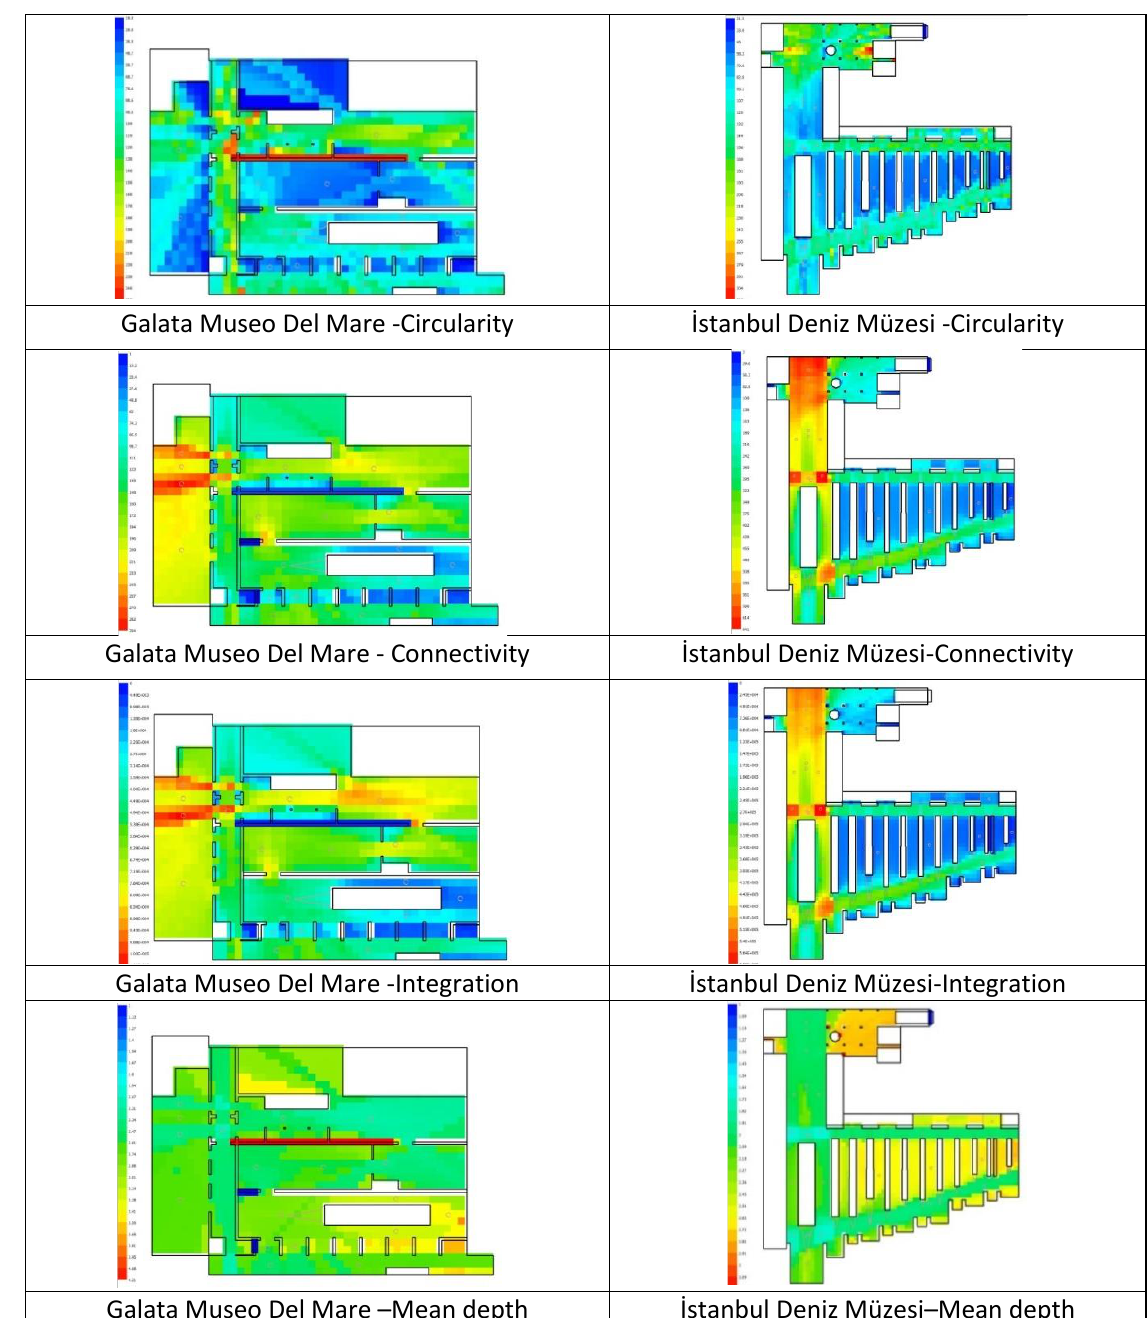
Figure 11 The circularity, connectivity, integration, and mean depth